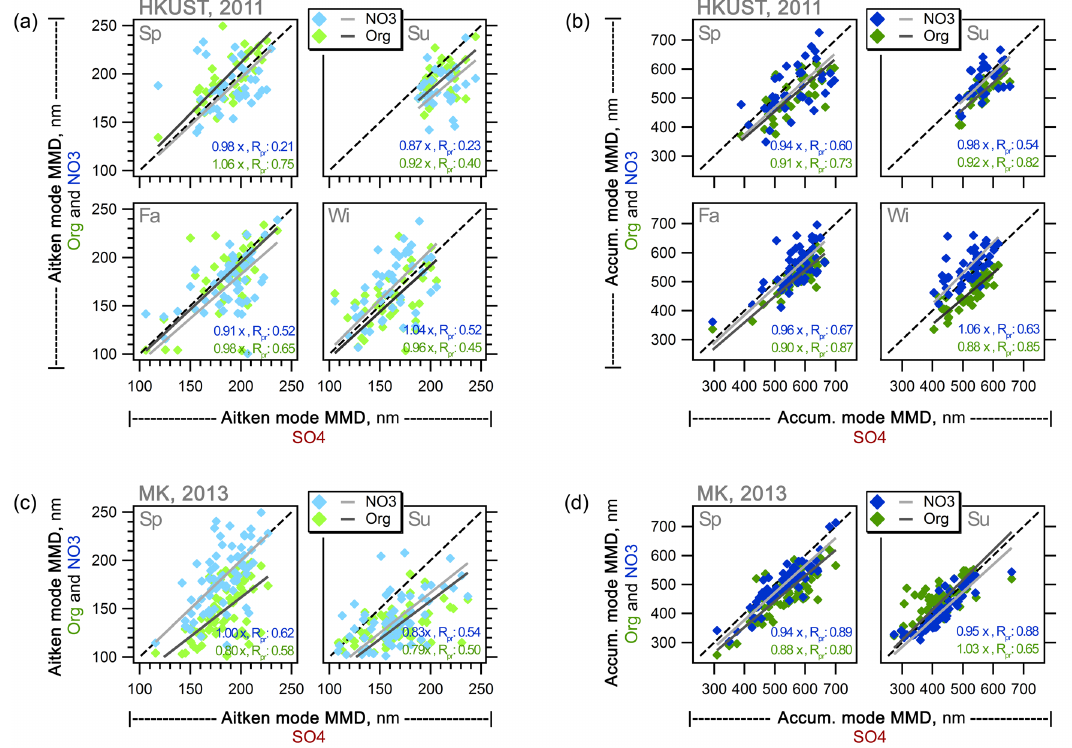
Figure 6. Scatter plots of fitted mass median diameters of organics and nitrate vs. sulfate for (a) the Aitken mode and (b) the accumulation mode at the HKUST suburban site and (c) the Aitken mode and (d) the accumulation mode at the urban Mong Kok